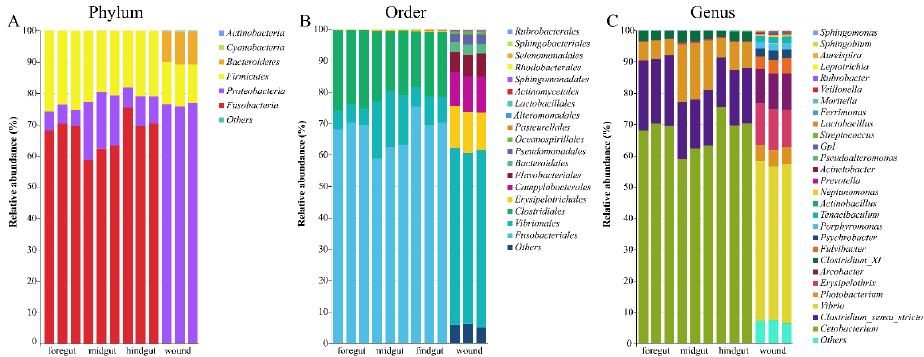
Figure 4. Relative abundance of the microbiome from the GI tract and skin wounds of an Indo- Pacific finless porpoise at the phylum level ( A ), order level ( B ), and genus level ( C ).